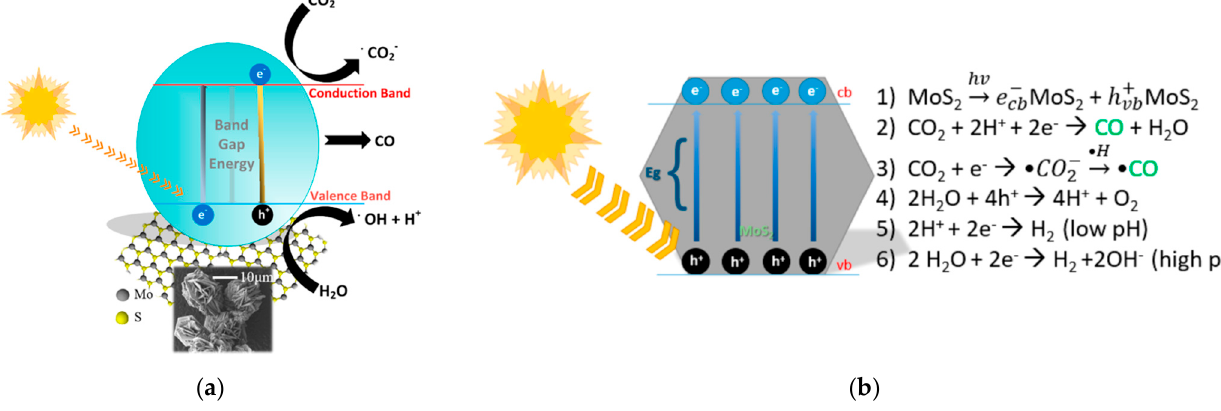
Figure 4. A schmatic diagram of CO 2 reduction mechanism using MoS 2 . ( a ) A schematic of MoS 2 acting as a catalyst for CO production. ( b ) A schematic showing photogenerated activity on MoS 2 surface and the chemical reactions for CO 2 reduction, CO formation, and H 2 O splitting. Adapted from [102]. American Chemical Society 2018.